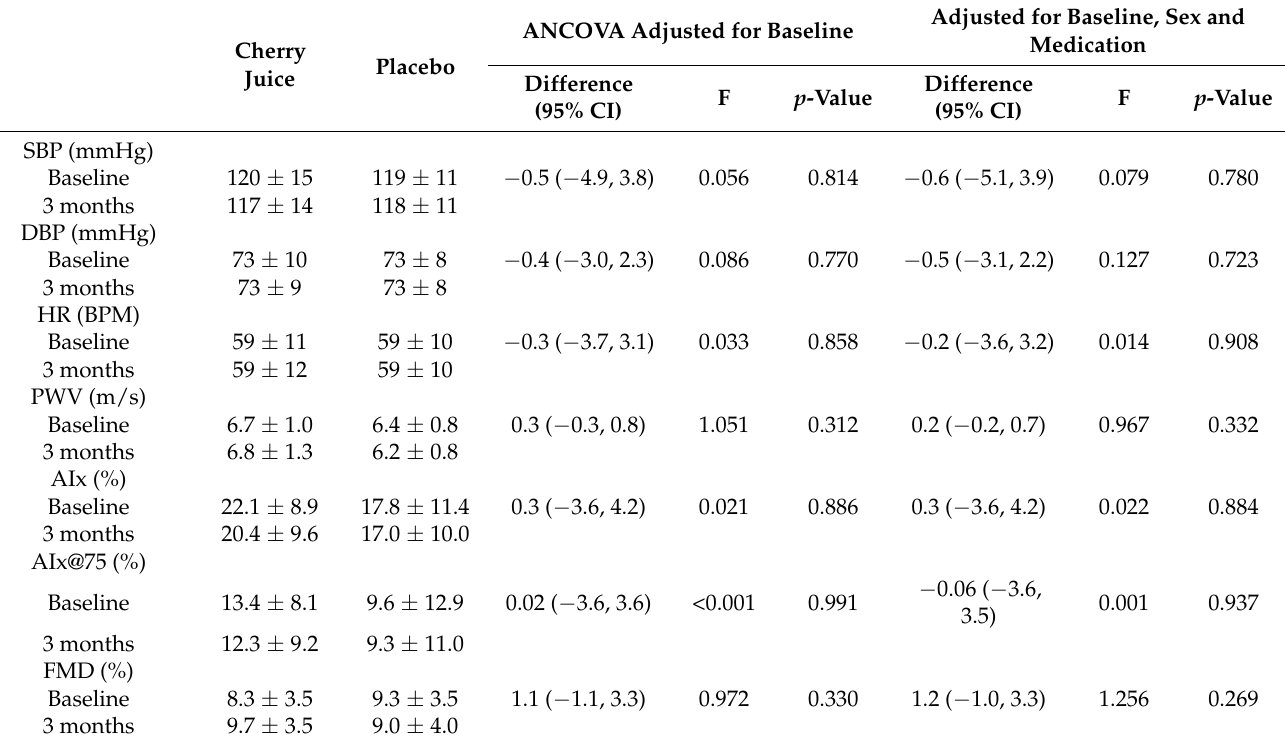
Figure 2. Systolic blood pressure before (left) and after 3-month supplementation (right) with cherry juice ( A ) and placebo ( B ). Table 3. Influence of tart Montmorency cherries on vascular function compared to a placebo.